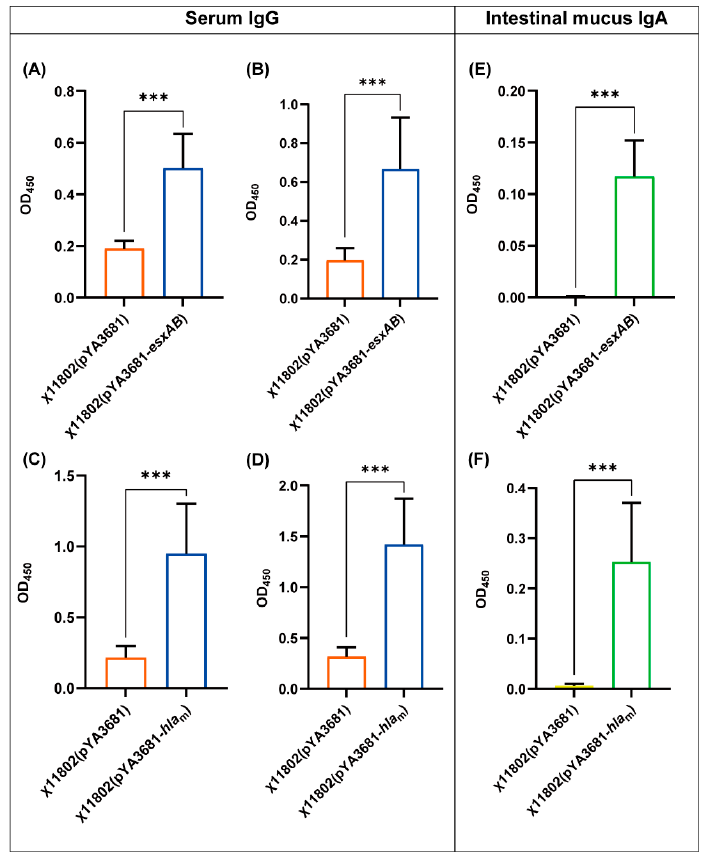
Figure 3. Antigen-specific IgG and IgA immune responses after BALB/c mice were orally adminis- trated with recombinant strains of χ 11802. In ( A – E ), mice were orally administrated with χ 11802(pYA3681), χ 11802(pYA3681 − esxAB ), or χ 11802(pYA3681 − hla m ). ( A , B ) Serum anti-rEsxAB specific IgG level on day 14 after primary and booster immunization. ( C , D ) Serum anti-rHla m specific IgG level on day 14 after primary and booster immunization. ( E , F ) Intestinal mucus anti-rEsxAB and anti-rHla m specific IgA level on day 7 after booster immunization. *** p <